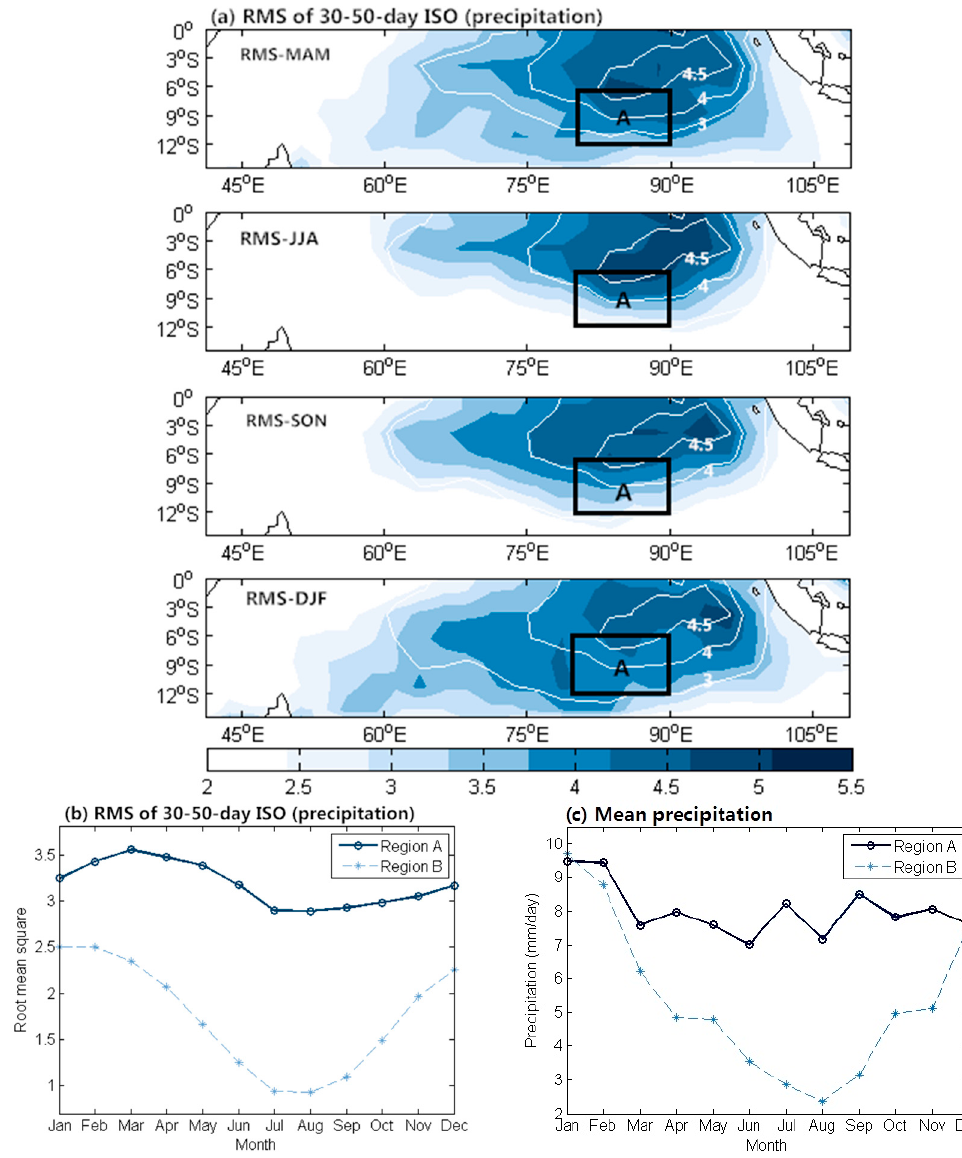
Figure 5. ( a ) RMS variance distribution of 30–50-day precipitation (mm/day) for the whole study period (contours) and different seasons (color shade); spatial-averaged; and ( b ) RMS variance; and ( c ) mean precipitation in Regions A and B as a function of calendar month during 1982 – 2016.